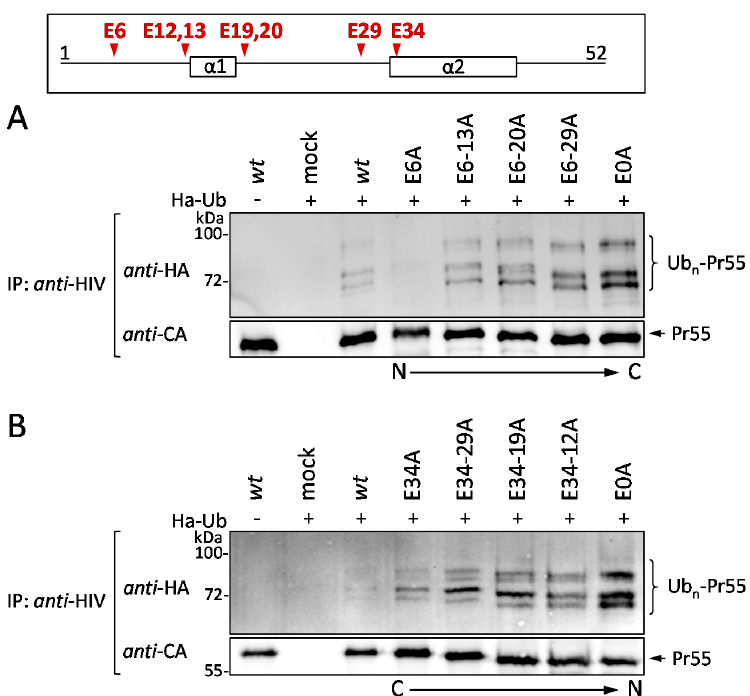
Figure 6. Successive mutation of the glutamic acids in p6 gradually increases HIV-1 Gag ubiquitination. ( A , B ) HeLa cells were co-transfected with HA-tagged ubiquitin and pNL env 1 expression plasmids as indicated. Gag was immunoprecipitated from whole cell lysates using anti -HIV antibodies and Gag ubiquitination was detected by western blot stained for HA. The amount of precipitated Gag was detected by anti -CA staining.